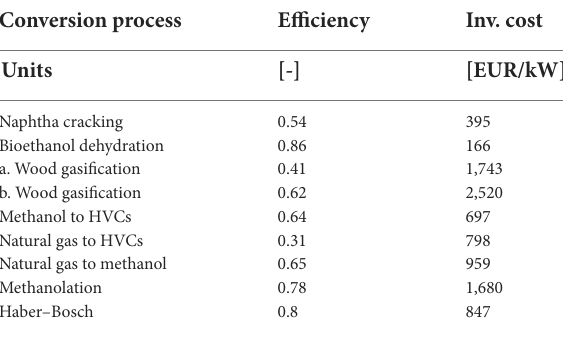
TABLE 3 Investment cost and efficiency of the conversion processes represented in Figure 1 for the satisfaction of the non-energy demand. References to the values provided can be found in Limpens